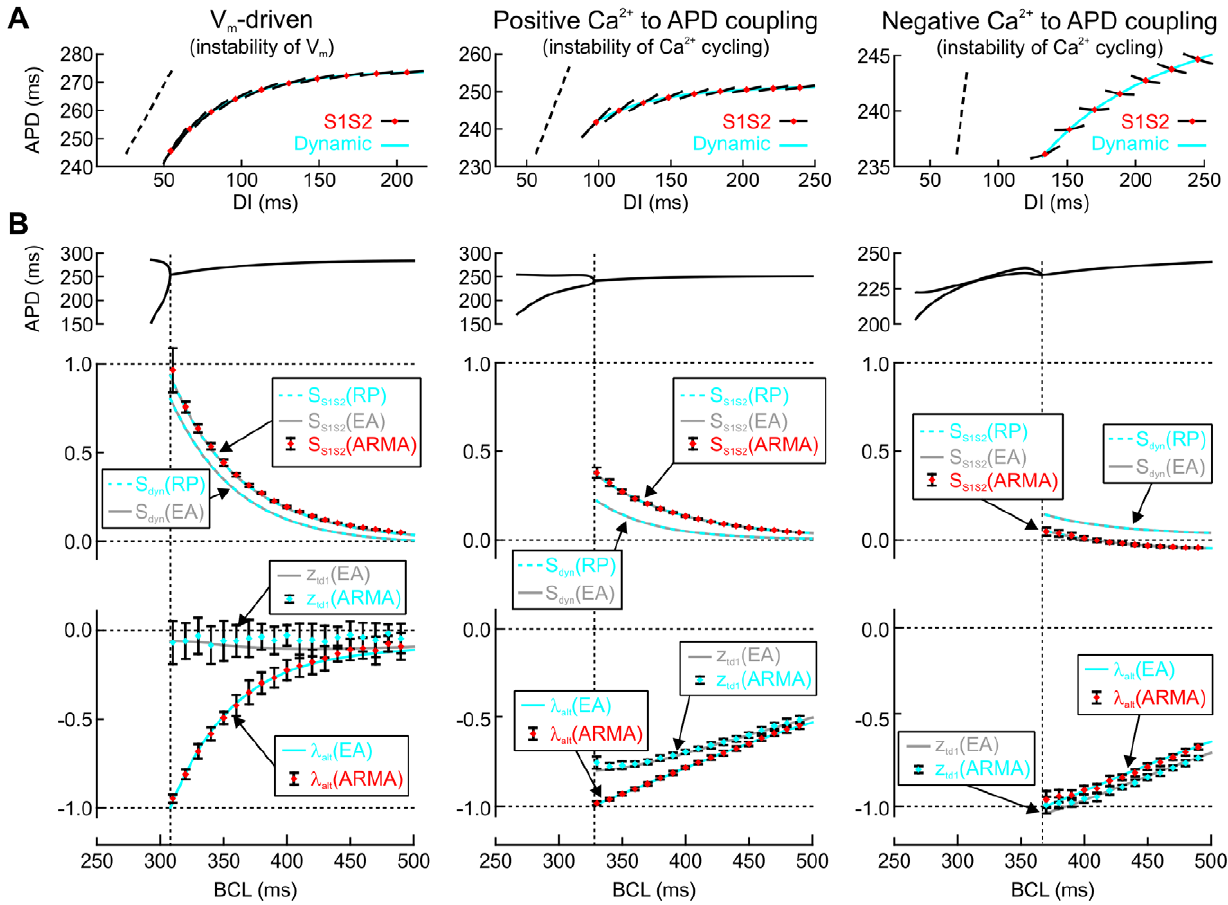
Figure 4. Behavior of alternans markers in the three model versions. A : Restitution portraits of APD vs. DI established using a dynamic restitution protocol combined with S1S2 protocols (close-ups of Figure 2). Each portrait consists of a dynamic restitution curve and a family of S1S2 restitution curves at various BCLs. These S1S2 restitution curves are only shown in the neighborhood of their intersections with the dynamic restitution curve (operation points, red diamonds). The oblique dotted lines denote a slope of 1. B : APD bifurcation diagrams (close-ups of Figure 1 A ), conventional slopes (S S1S2 and S dyn ) and transfer function markers (alternans eigenvalue l alt and first zero of the transfer function H t R d z td1 ) as a function of BCL, identified using eigenmode analysis (EA), conventional restitution protocols (RP), and ARMA model identification during stochastic pacing (SD of CL: 5 ms), respectively. ARMA model identification was conducted on series of 30 successive cycles using a 3 rd order model; data points with error bars represent mean 6 SD for n =37 simulations. Vertical dotted lines denote the BCL at which alternans appears.